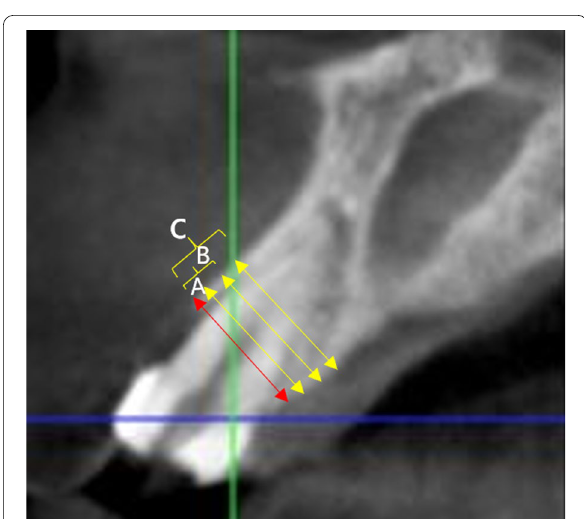
Fig. 4 Volumetric changes. horizontal measurements. The red line is the baseline, A line is 1 mm below the reference line, B line is 3 mm below the baseline line, and C line is 5 mm below the baseline line